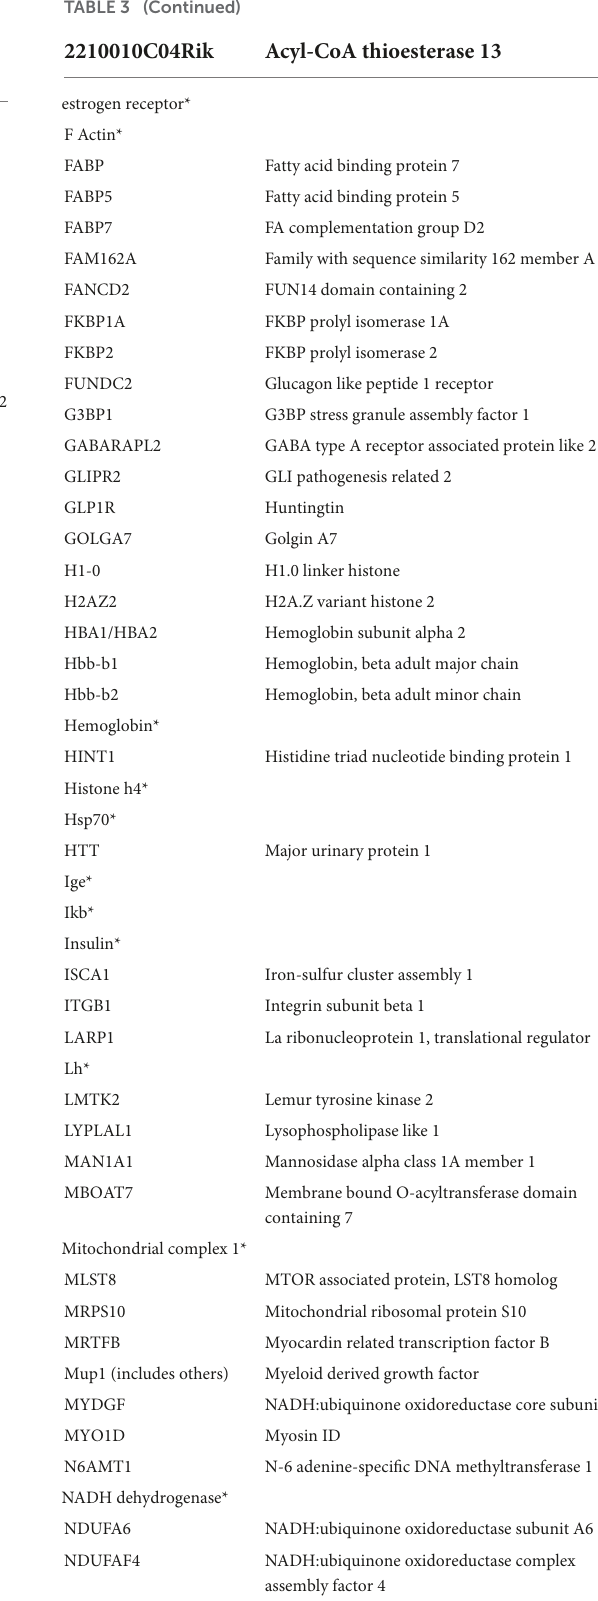
TABLE 3 List of proteins from Tables 1–5 with their symbol and gene